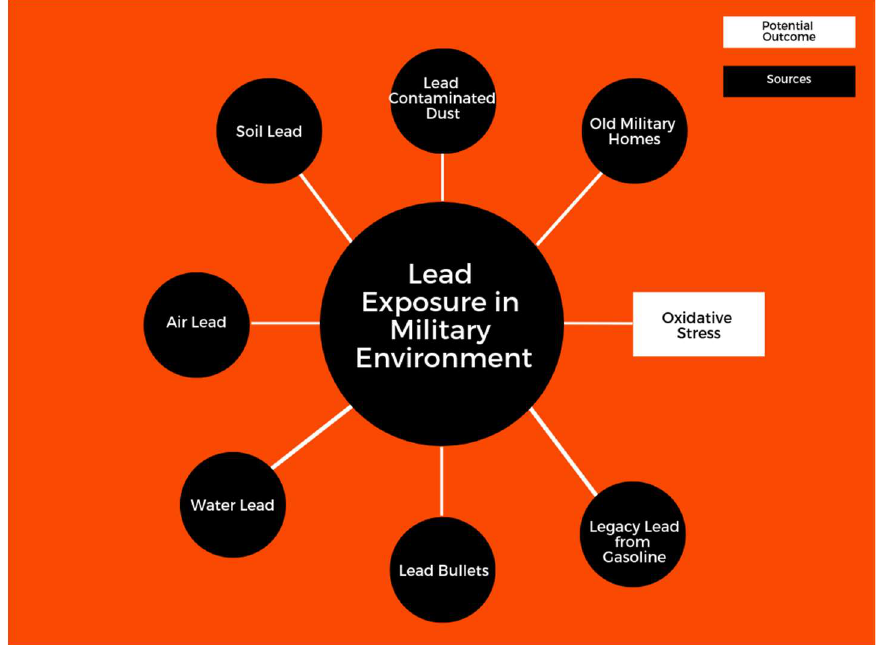
Figure 1. Sources of lead exposure in military environments.